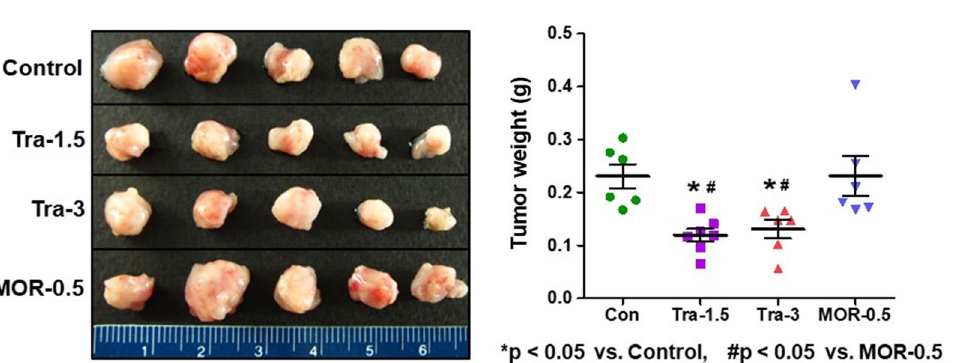
Figure 2. Comparison of tumor size and weight. Tumors were resected from mice 4 weeks after orthotopic inoculation of MCF7-Luc cells. *p < 0.05 vs . Con., # p < 0.05 vs . MOR-0.5. Con., control group; Tra-1.5,